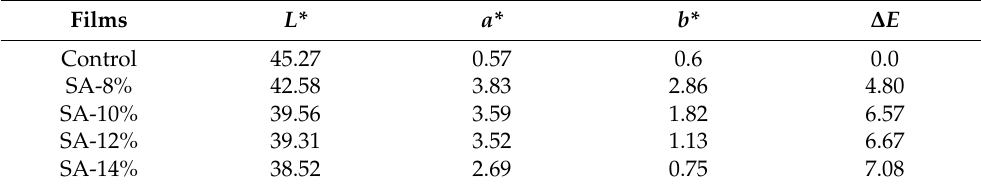
Table 2. Colour parameters including L, a, b, and ∆ E of control and RCA-containing films. Films